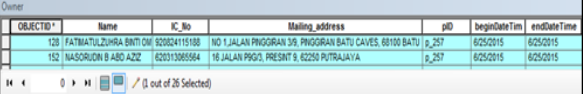
Figure 6. The result in Owner table after related with MY_Party